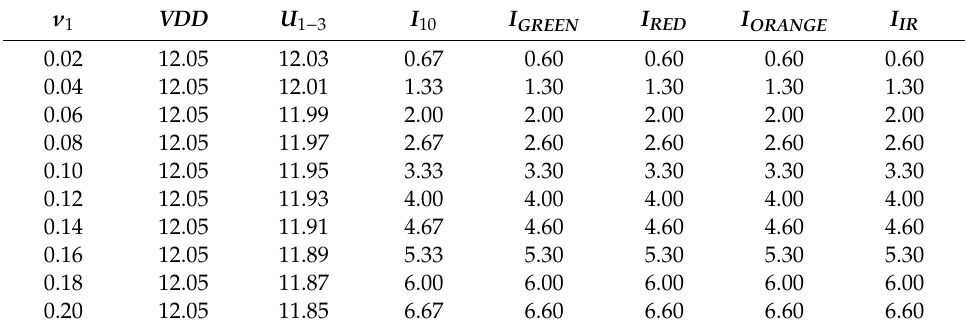
Table 1. The relationship between the input voltage 𝑣 1 (V) and the current 𝐼 (mA) through the designated LED, where VDD is the drain voltage.